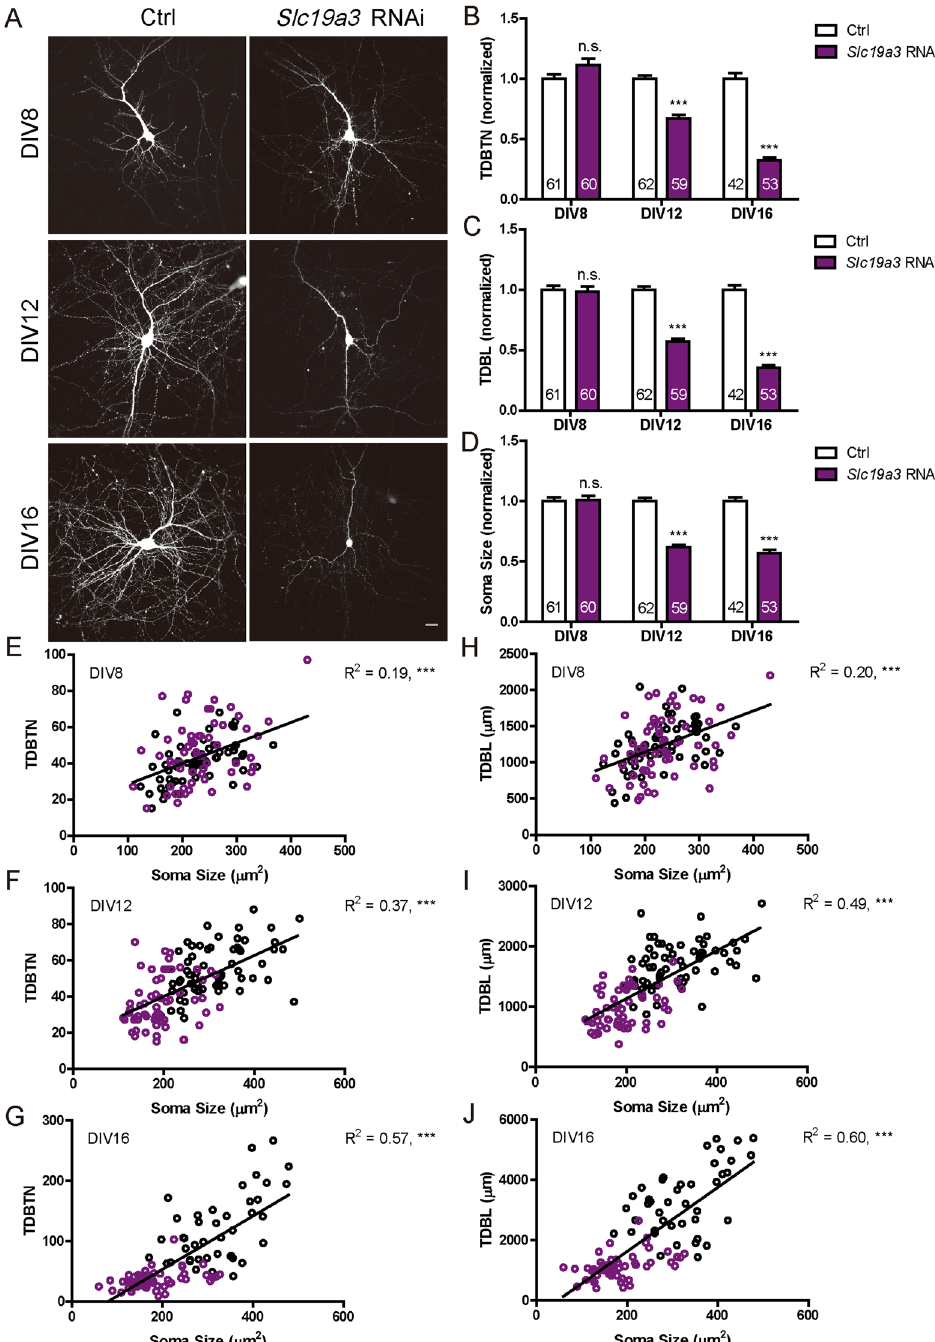
Figure 5. Slc19a3 knockdown in primary hippocampal neurons significantly reduced TDBTN, TDBL and soma size. ( A ) Representative images of primary hippocampal neurons transfected with control and Slc19a3 RNAi constructs, fixed at DIV8, DIV12 or DIV16. Scale bar: 20 μ m. ( B ) Quantitation of TDBTN: Slc19a3 RNAi at DIV8 (1.11 ± 0.05, n.s.), DIV12 (0.67 ± 0.03, P < 0. 001), DIV16 (0.32 ± 0.02, P < 0. 001). ( C ) Quantitation of TDBL: Slc19a3 RNAi at DIV8 (0.98 ± 0.04, n.s.), DIV12 (0.57 ± 0.02, P < 0. 001), DIV16 (0.35 ± 0.02, P < 0. 001). ( D ) Quantitation of soma size: Slc19a3 RNAi at DIV8 (1.01 ± 0.03, n.s.), DIV12 (0.62 ± 0.02, P < 0. 001), DIV16 (0.57 ± 0.03, P < 0. 001). ( B – D ) Two way ANOVA followed by Bonferroni’s post-test. ( E – G ) Significant correlations exist between TDBTN and soma size at DIV8 ( E , n = 121, R 2 = 0.19, P < 0. 001), DIV12 ( F , n = 121, R 2 = 0.37, P < 0. 001) and DIV16 ( G , n = 95, R 2 = 0.57, P < 0. 001). ( H – J ) Significant correlations are observed between TDBL and soma size at DIV8 ( H , n = 121, R 2 = 0.20, P < 0. 001), DIV12 ( I , n = 121, R 2 = 0.49, P < 0. 001) and DIV16 ( J , n = 95, R 2 = 0.60, P < 0. 001). In ( E – J ) Black circles represent control neurons, while purple circles represent Slc19a3 RNAi